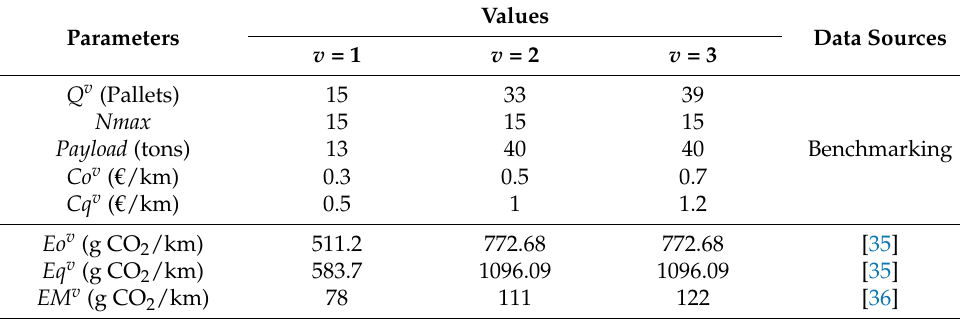
Table 5. The required data for the vehicles in